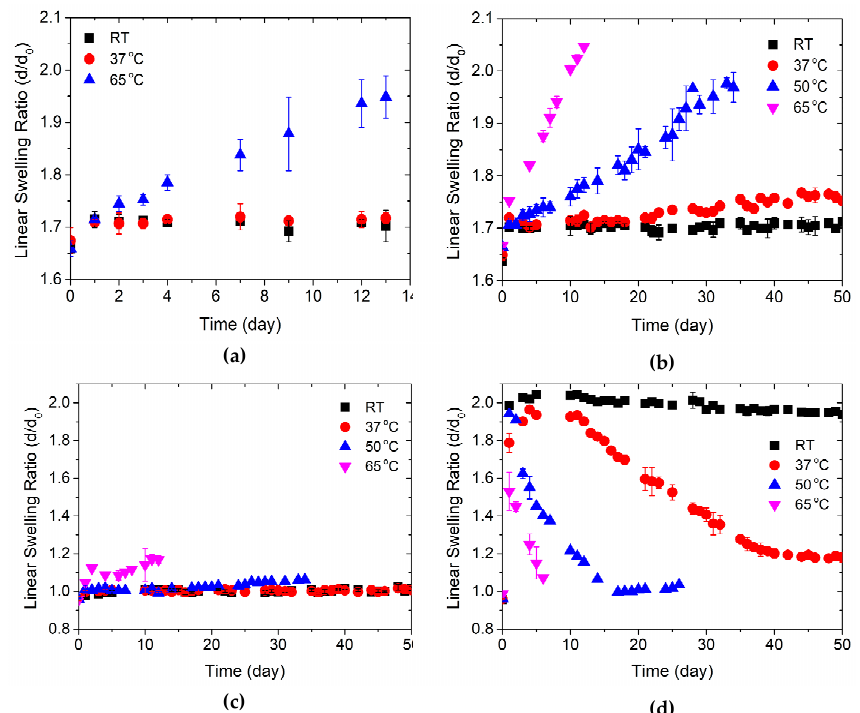
Figure 5. Swelling and shrinking kinetics at various temperatures in ( a ) pAAm hydrogels incubated in phosphate buffered saline (PBS); ( b ) pAAM hydrogels incubated in PBS with 9 mM fructose; ( c ) p(AAM- co -MPBA) hydrogels incubated in PBS; and ( d ) p(AAM- co -MPBA) hydrogels incubated in PBS with 9 mM fructose. In all cases, pH = 7.4 and ionic strength = 0.155 mM. All measurements performed in duplicate. RT denotes room temperature (25 °C).